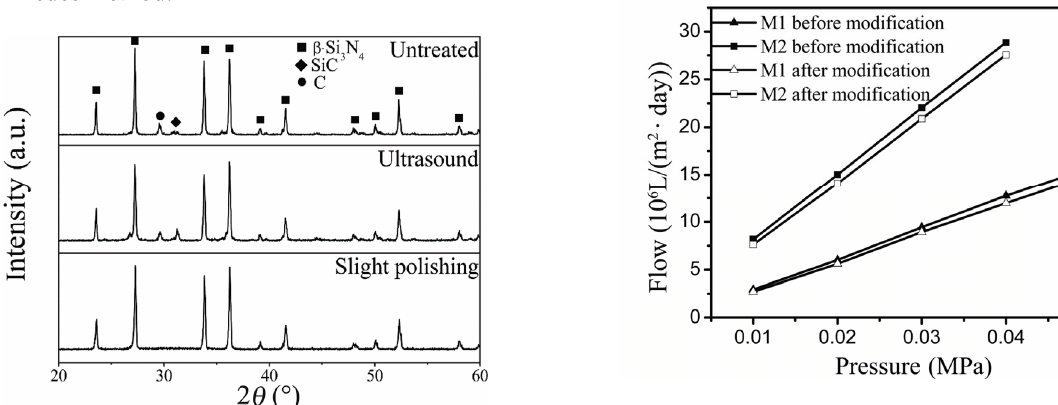
Fig. 6 Gas permeation of the membranes before and after